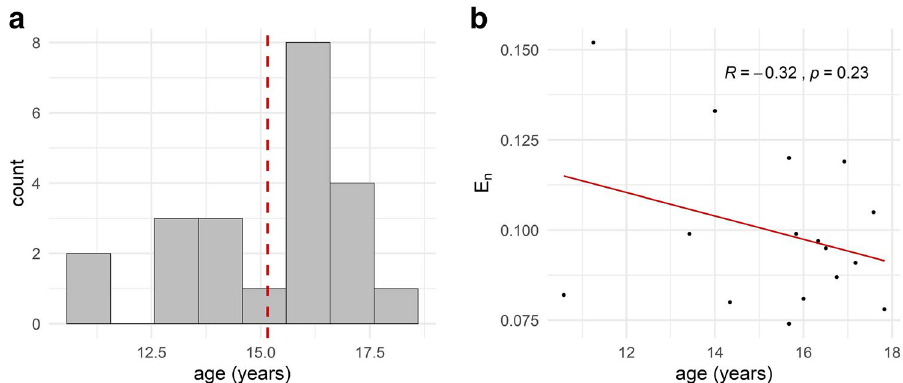
Figure 1. Age and individual normal E-field component (E n ). (a) Age distribution of the whole sample size (n = 22). Red line indicates mean age of 15.18 years. (b) Correlation of age and normal E-field component (E n ) (n = 16).